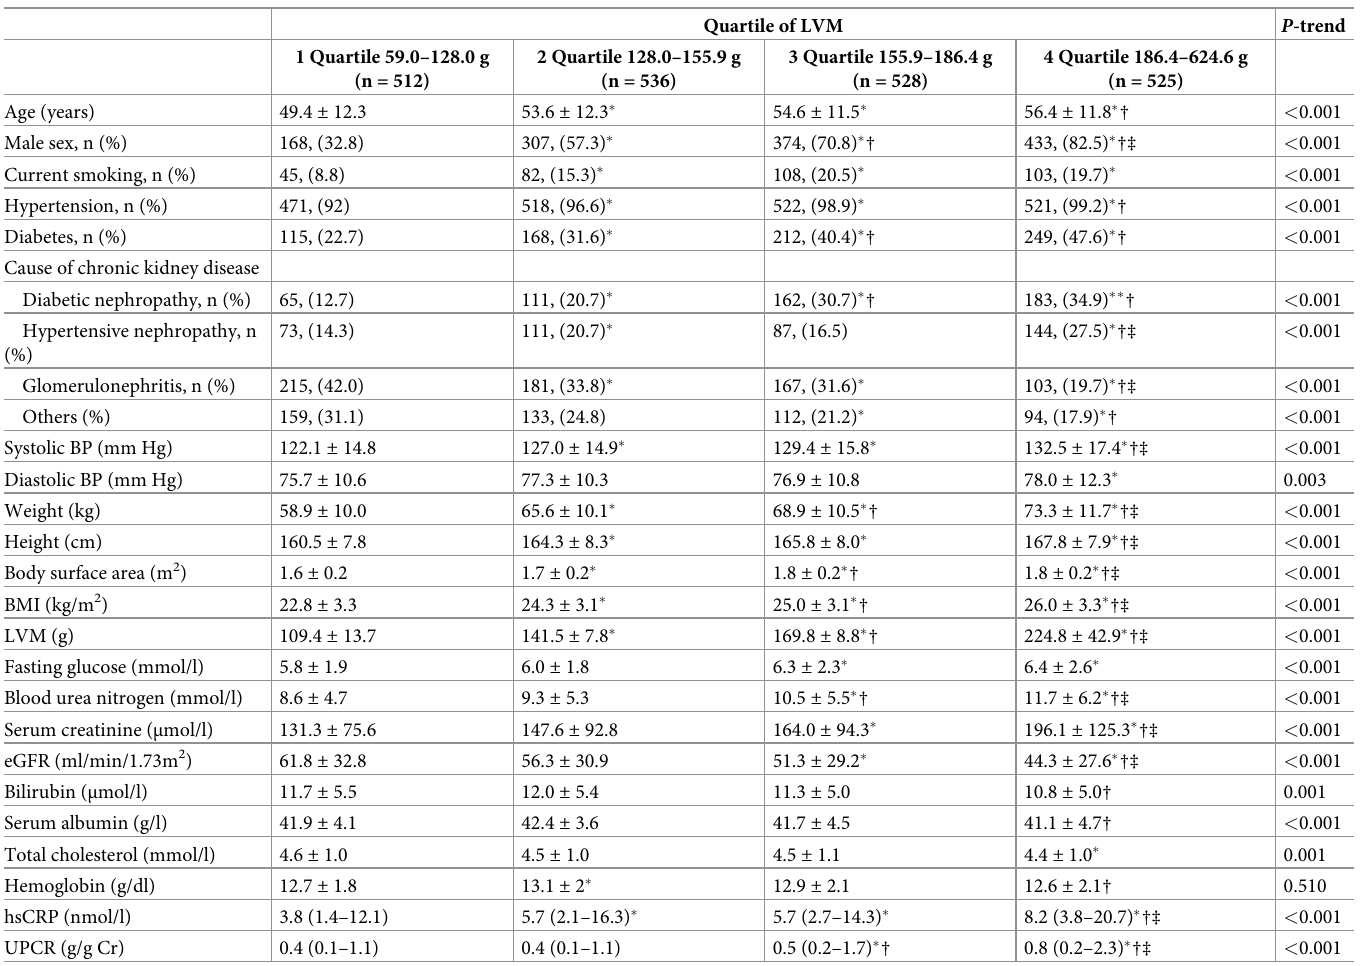
Table 1. Baseline characteristics of patients according to the status of left ventricular mass.